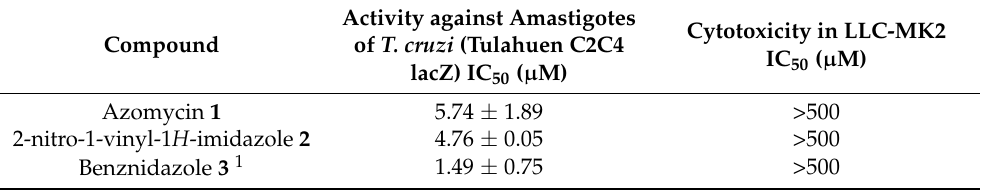
Table 1. Results of biological activity for 2-nitro-1-vinyl-1 H -imidazole and its precursor